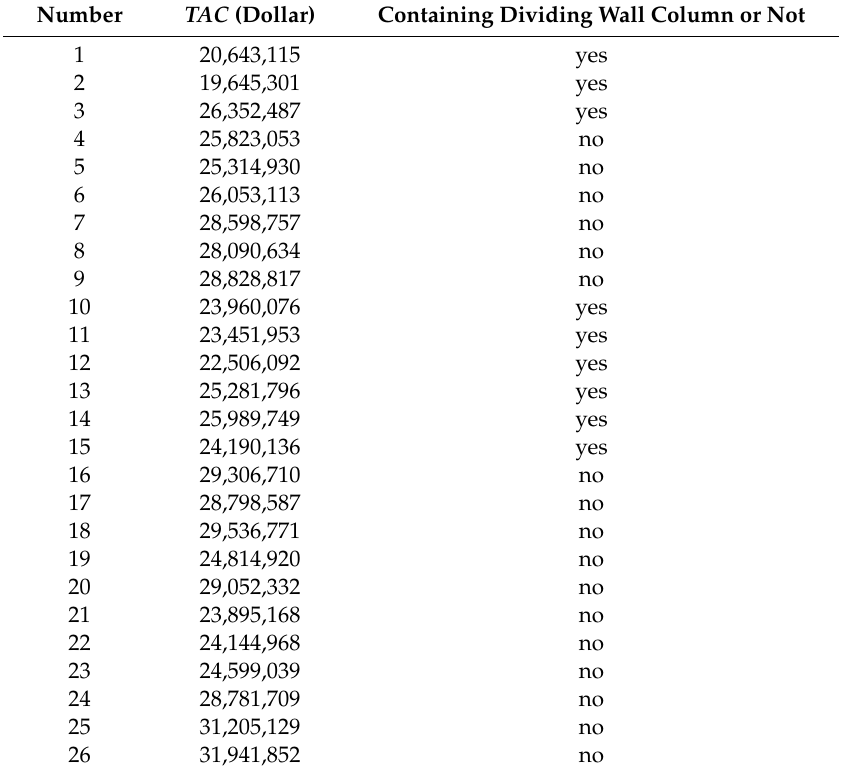
Table 7. The costs of nonsharp sequences of the four-component alkane case.